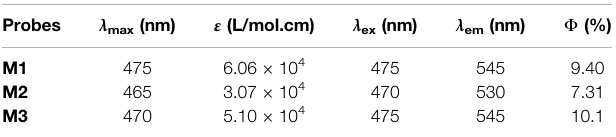
TABLE 1 | Optical properties of probes M1 , M2 , and M3